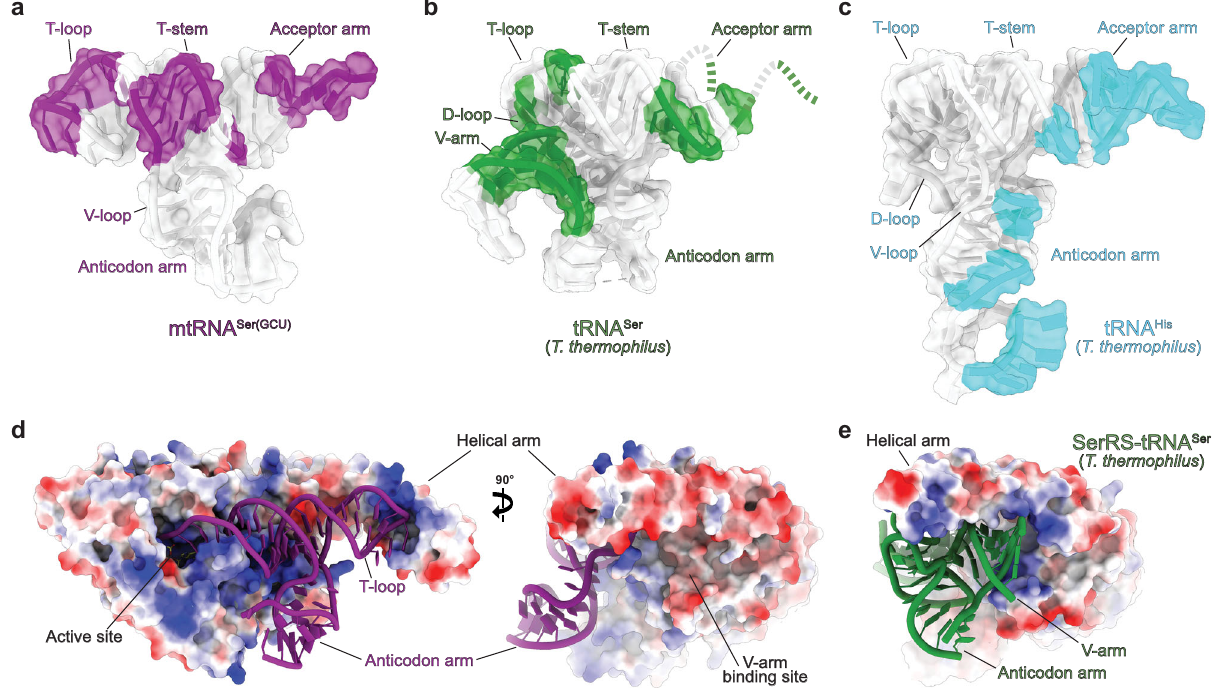
Fig. 3 | The reshaped interface between mSerRS and mtRNA Ser(GCU) . a Surface regions (purple) of mtRNA Ser(GCU) in contact with mSerRS. Regions outside of the interface are shown in white. b Surface regions (green) of T. thermophilus tRNA Ser forming polar contacts with bacterial SerRS (PDB 1SER) 26,35 . c Surface regions (cyan) of T. thermophilus tRNA His in contact with HisRS (PDB 4RDX) 74 , showing a distribution across anticodon-D-arm and acceptor-T-arm domains typical for anticodon-recognizing aaRS-tRNA complexes. d Electrostatic